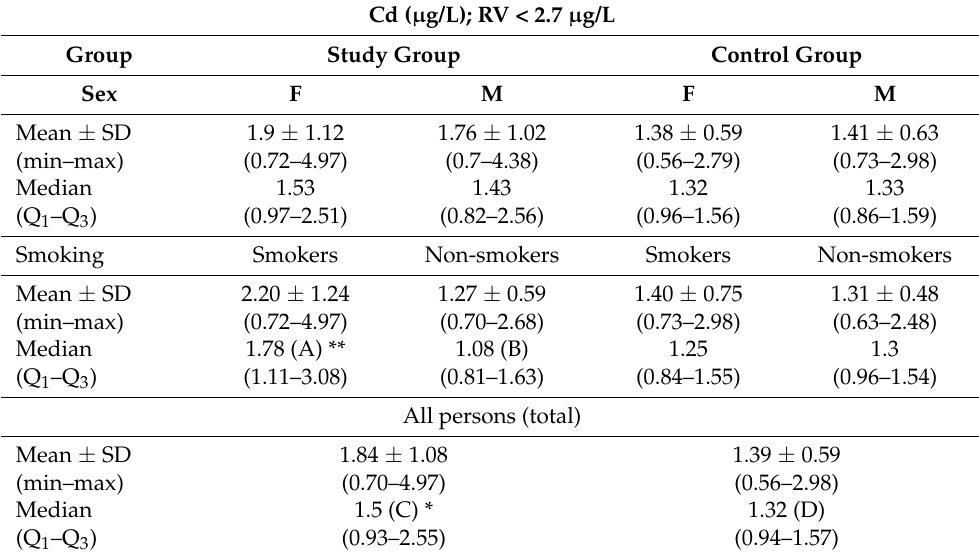
Table 3. The concentration of cadmium in the blood of patients with osteoarthritis of the spine and healthy